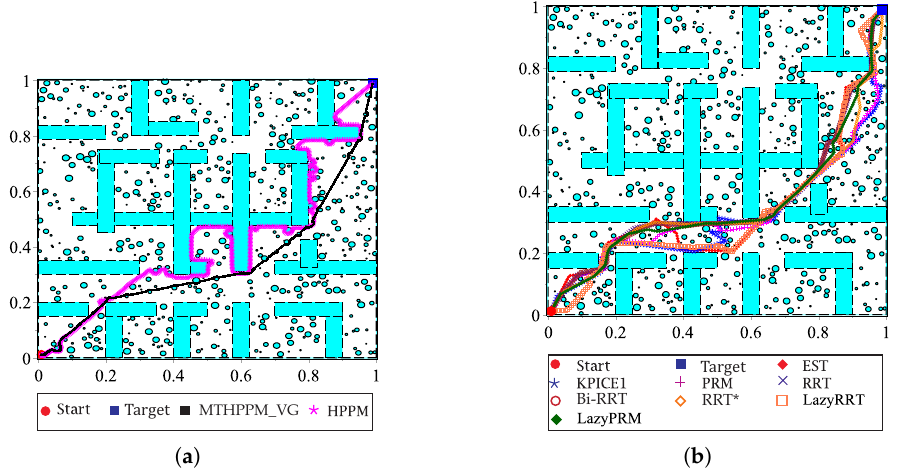
Figure 19. Visual comparative for case study 2 with five hundred obstacles; best run of each SBP algorithm. ( a ) Paths obtained with HPPM and MTHPPM_VG. ( b ) Paths obtained using SBP algorithms.